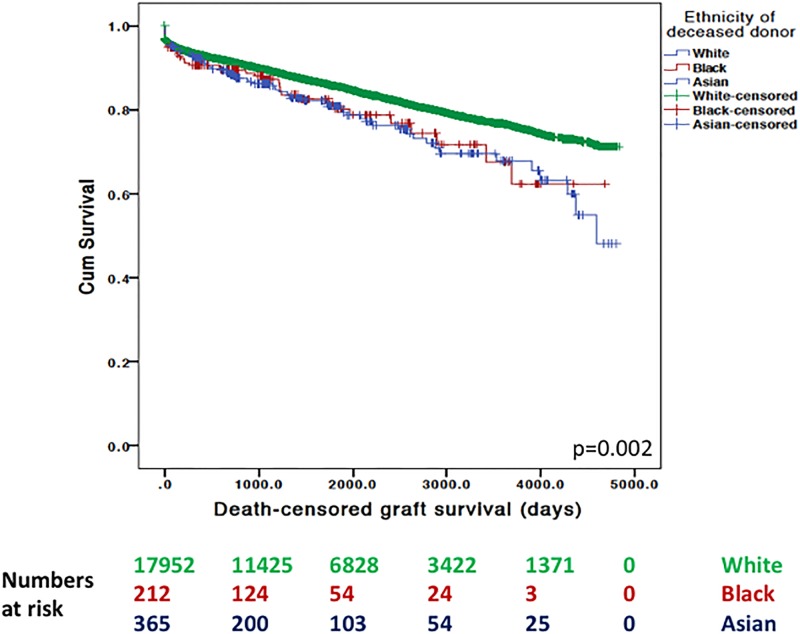
Unadjusted Kaplan-Meier survival plots of death-censored graft survival after deceased kidney donation based upon donor ethnicity.